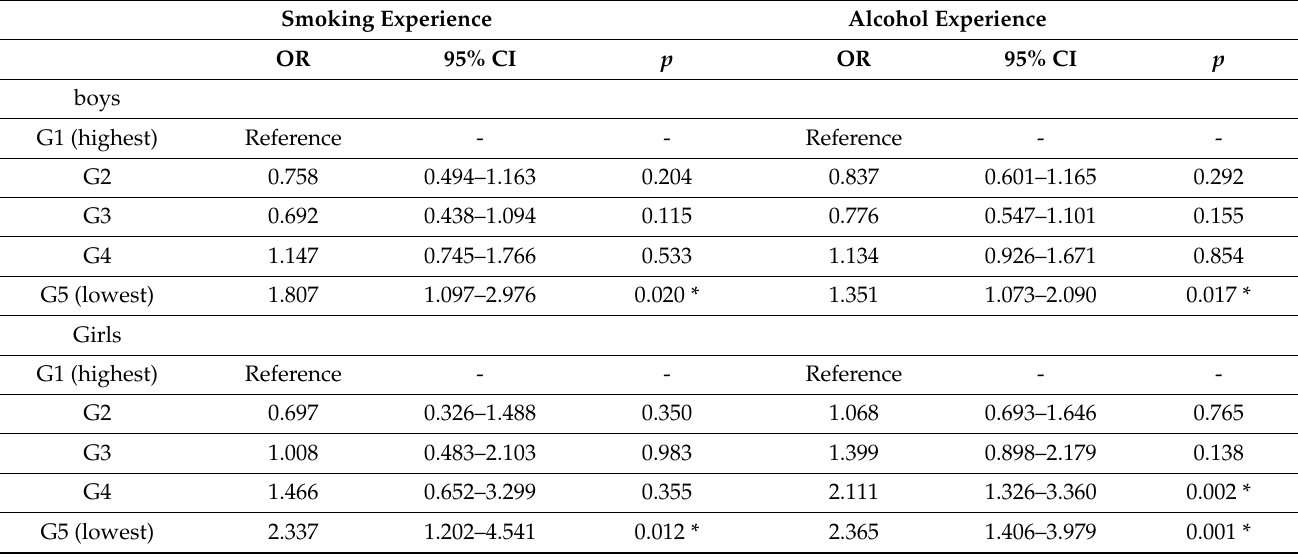
Table 5. Smoking and alcohol experience odds ratios according to household